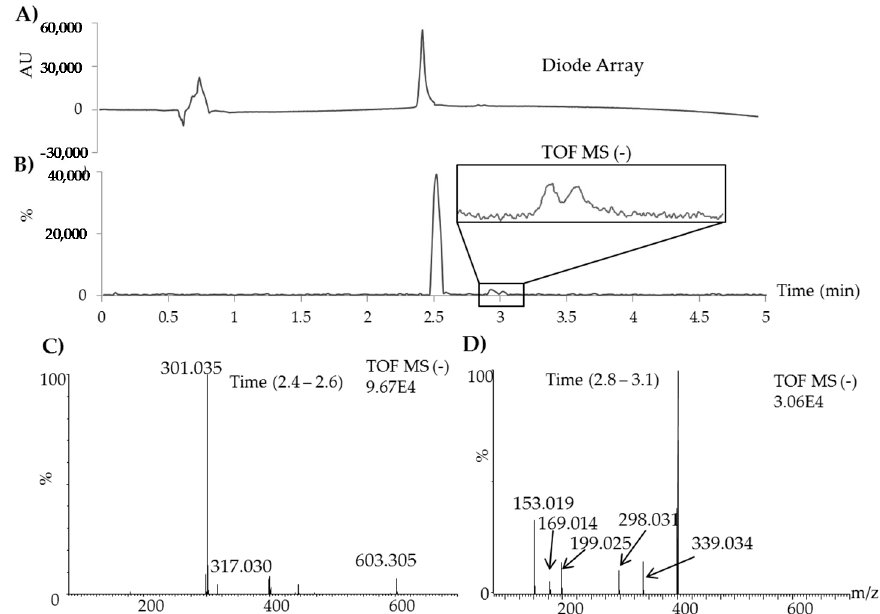
Figure 2. An ultrahigh performance liquid chromatography method with quadrupole time-of-flight detection (UHPLC-DAD-QTOF/MS) analysis of a treated sample of quercetin: ( A ) DAD chromatogram at 365 nm, ( B ) total ion current chromatogram in negative mode, ( C ) spectrum for the main peak, quercetin with some partly co-eluting degradation products, and ( D ) the spectrum for the other two peaks as degradation products of quercetin. The mass of m/z 400 is a background contamination, having also been detected in the blank injection solvent.